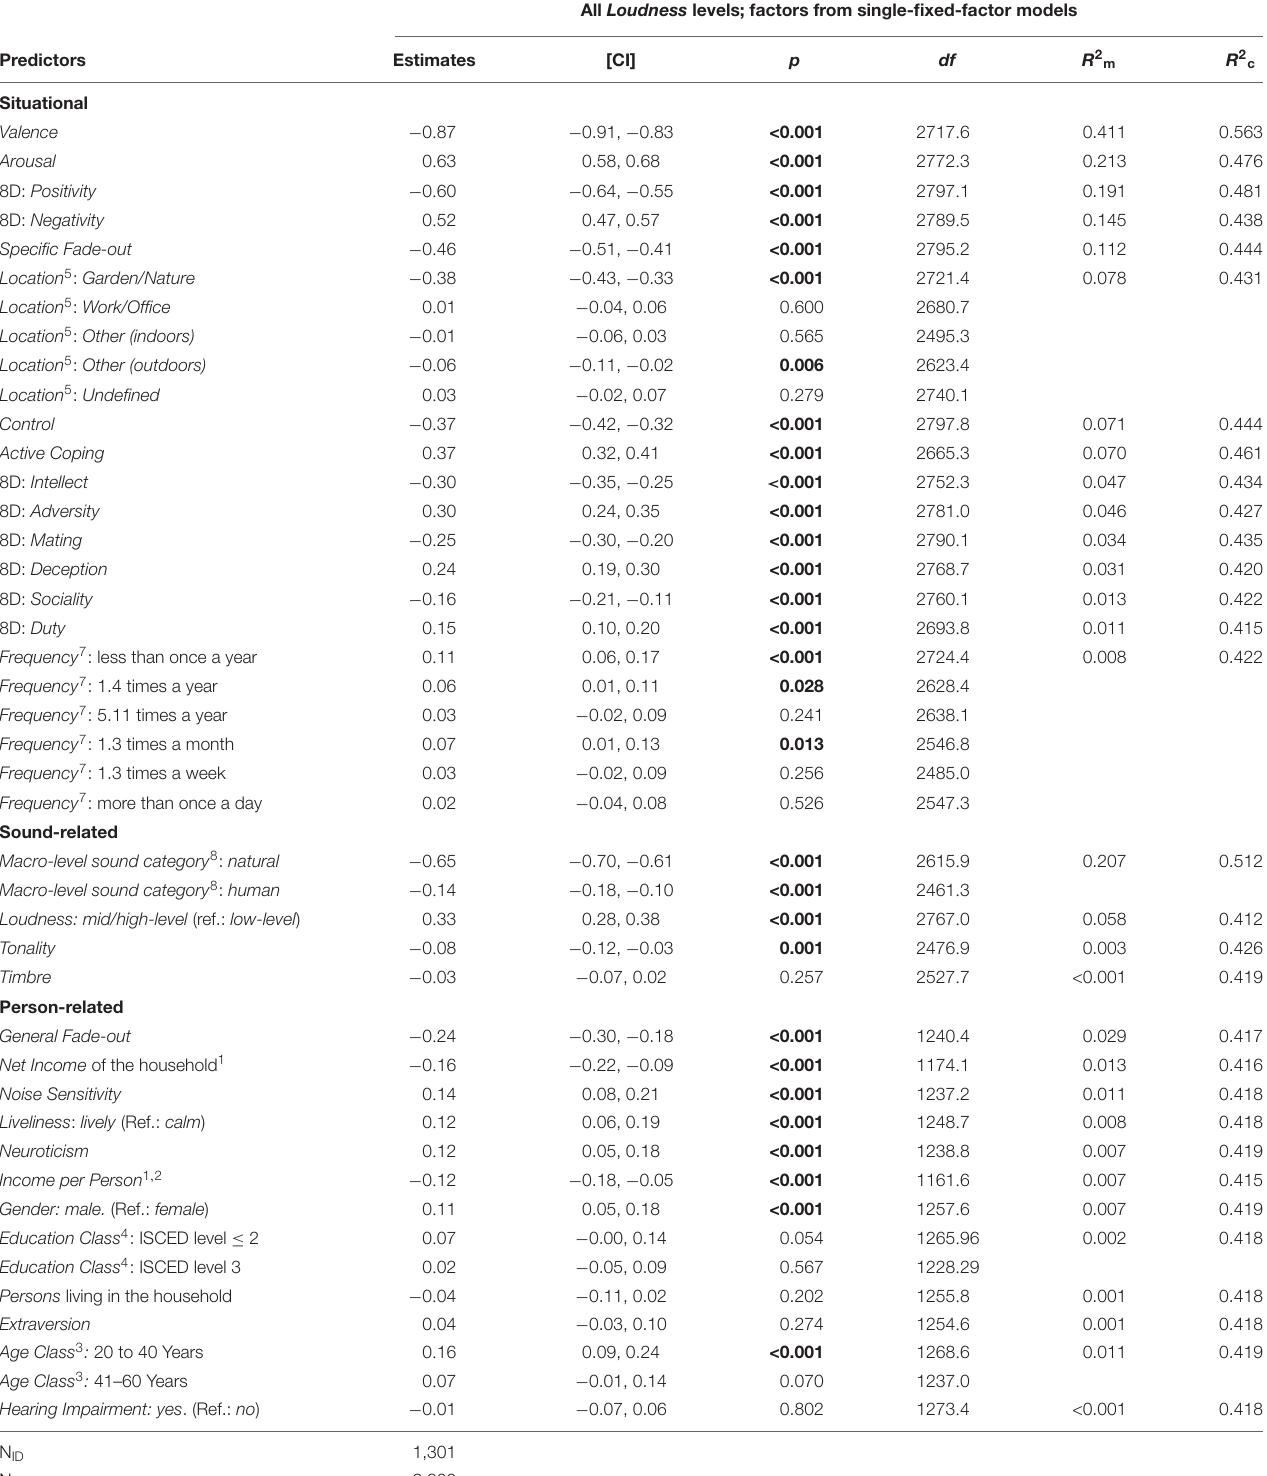
TABLE 4 | Annoyance estimates of bivariate single-fixed-factor models including dummy variables of each factor. All Loudness levels; factors from single-fixed-factor